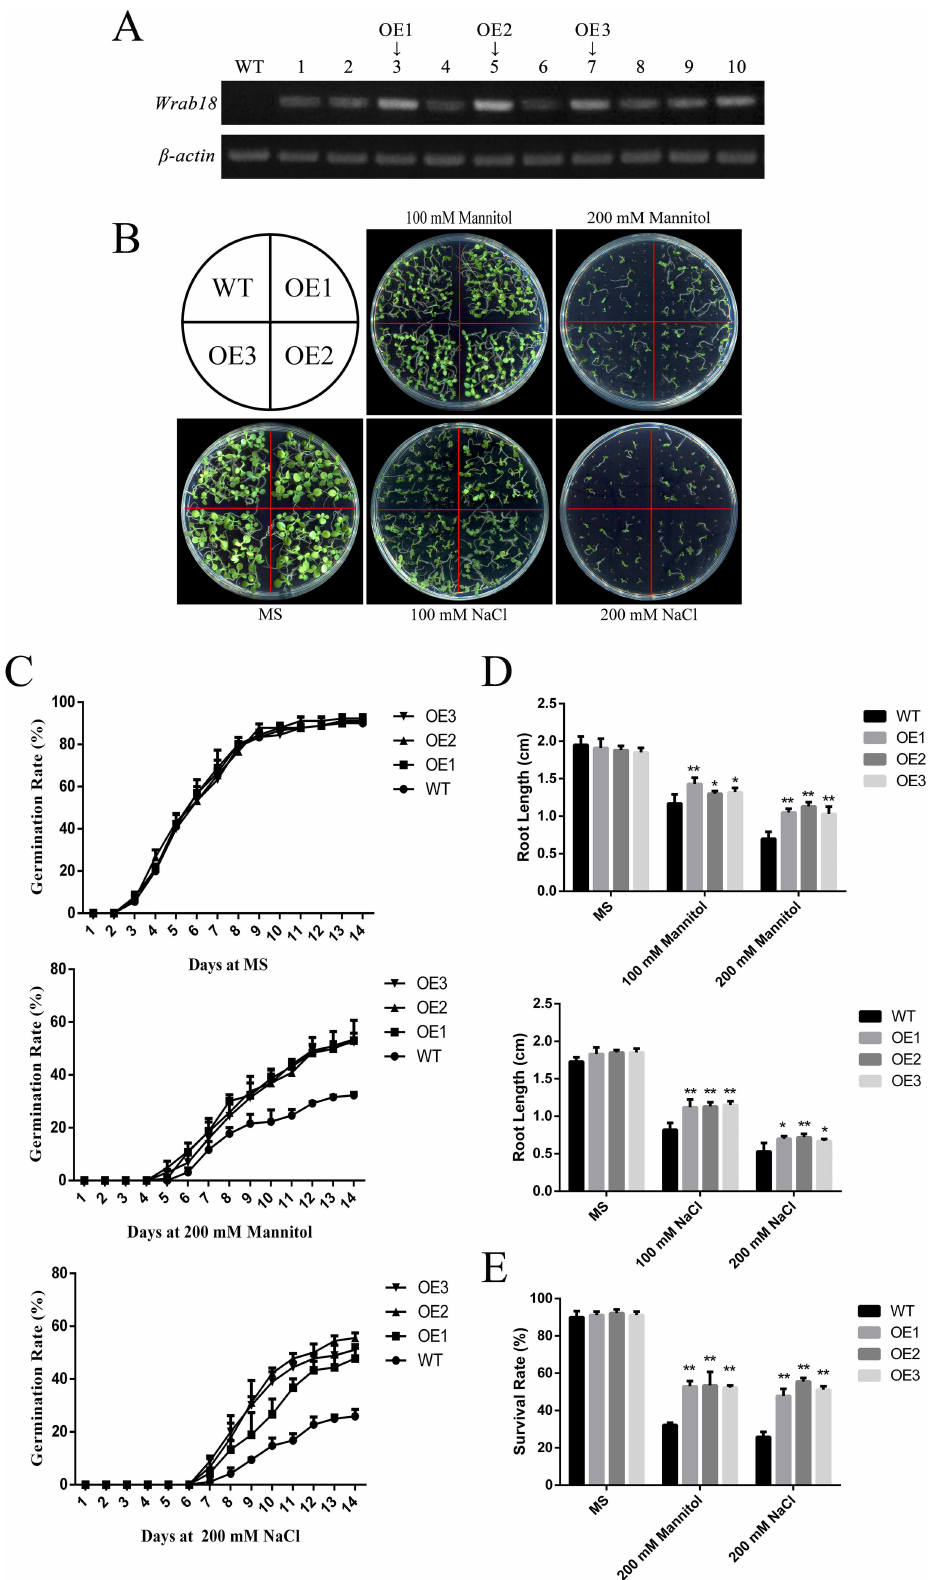
Fig 2. Drought and salinity tolerance in wild-type versus Wrab18 -overexpressing N . benthamiana plants. (A) Identification of transgenic tobacco plants by semi-quantitative PCR. (B) Phenotypic